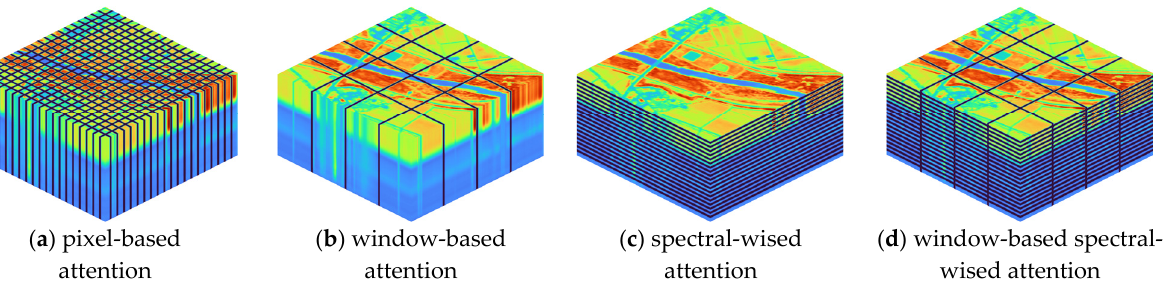
Figure 4. Four typical self-attention modules in the field of spectral reconstruction. The fourth one is used by SpectralMAE.